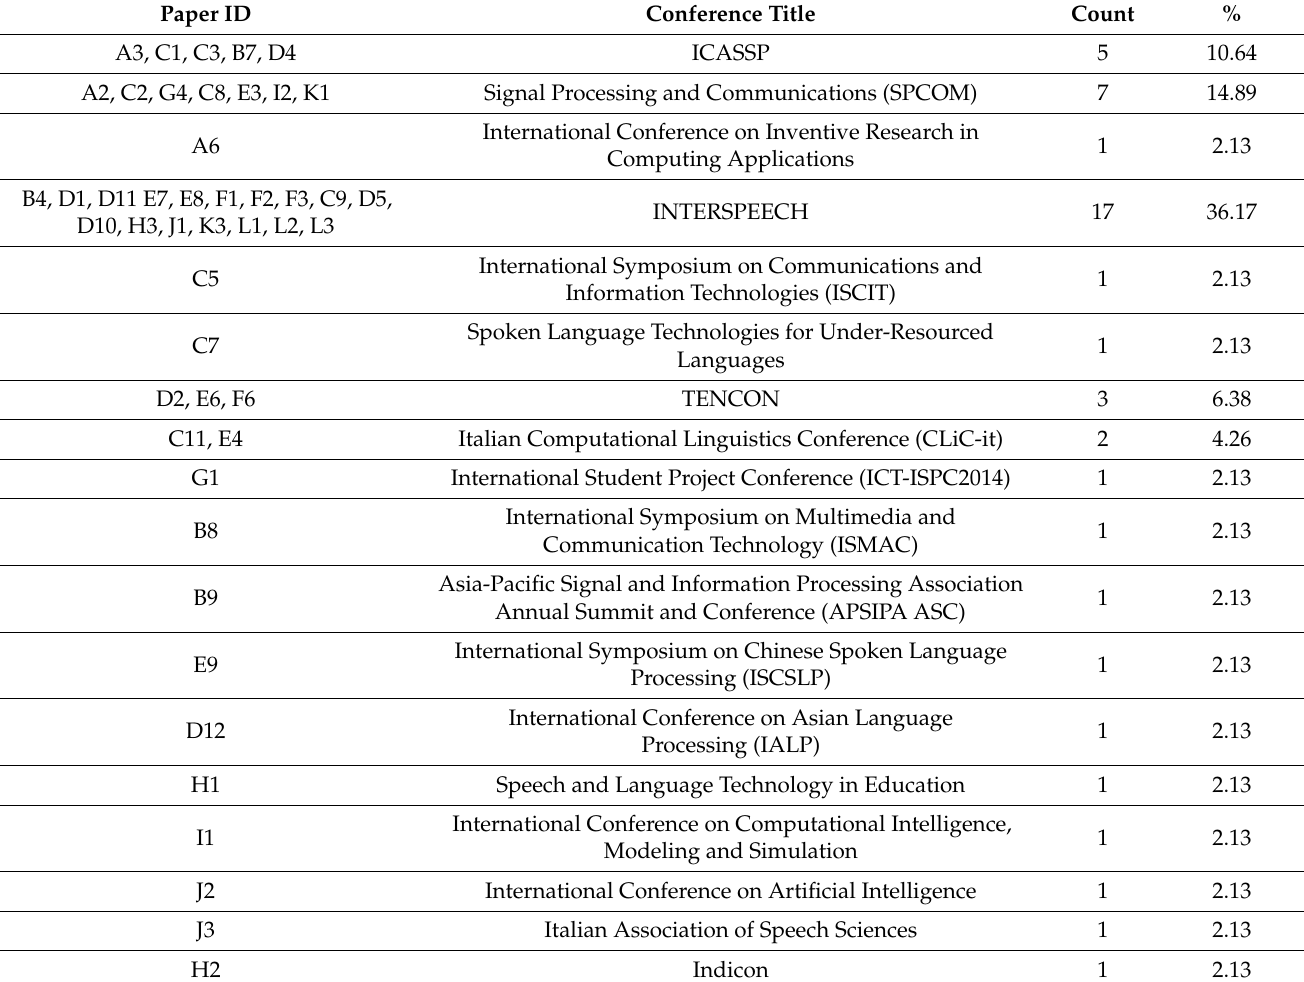
Table 2. Conference research papers included in the